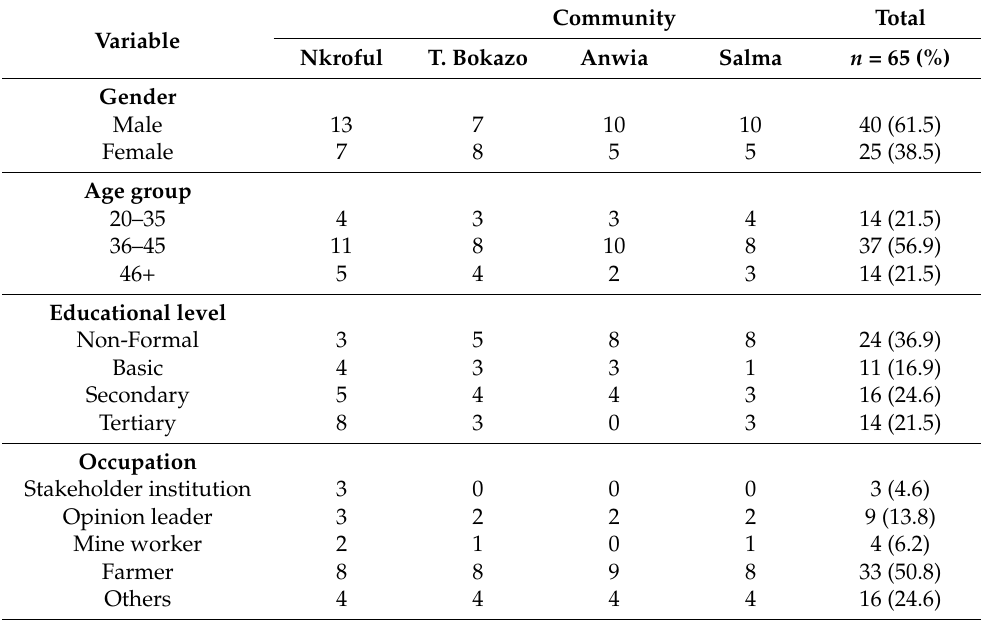
Table 1. Demographic characteristics of